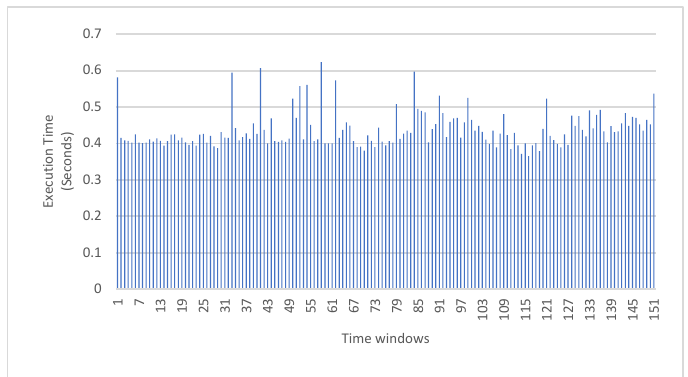
Figure 17. The execution time per time window.